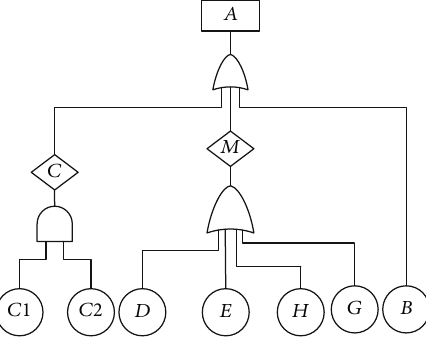
Figure 5: The FTA model of the IMA